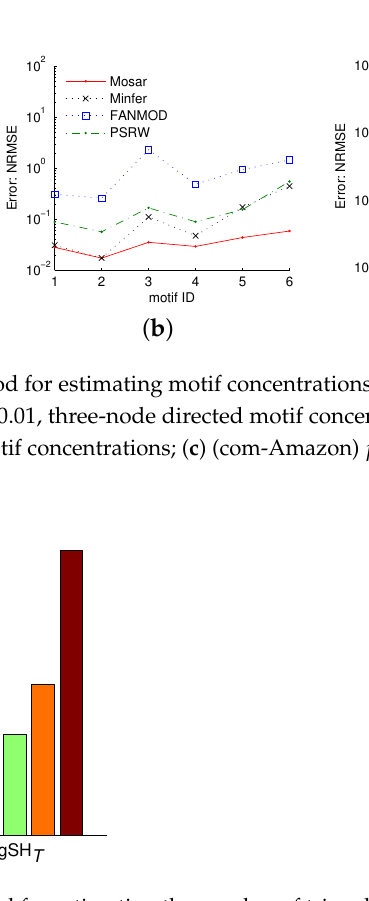
Figure 12. Accuracy of our method for estimating the number of triangles in comparison with gSH